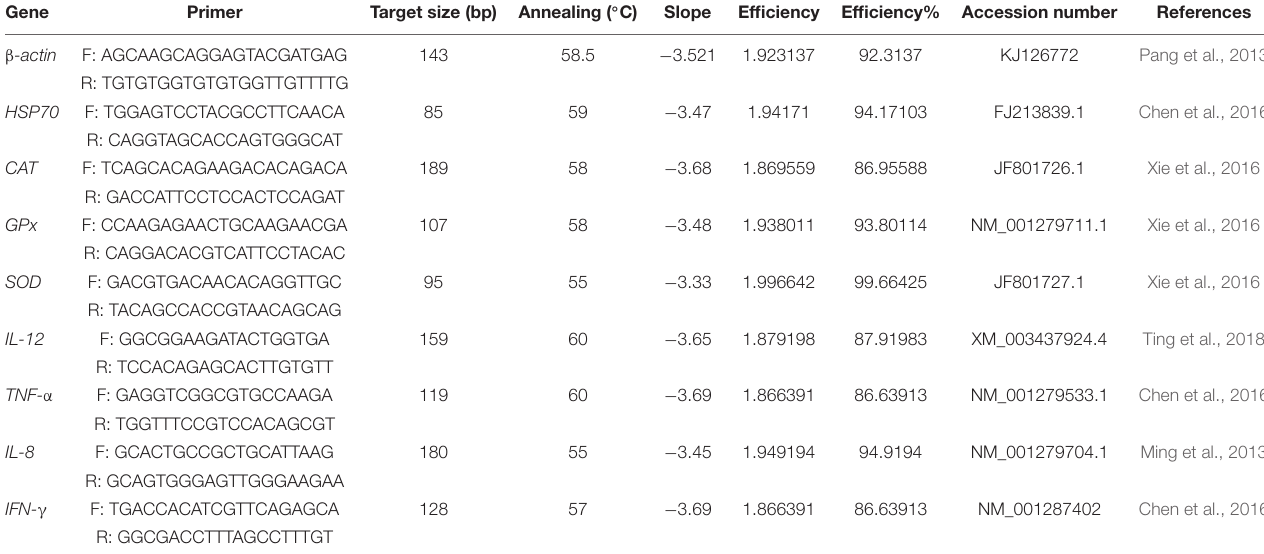
TABLE 2 | Primers used for qRT-PCR analysis. Gene Primer